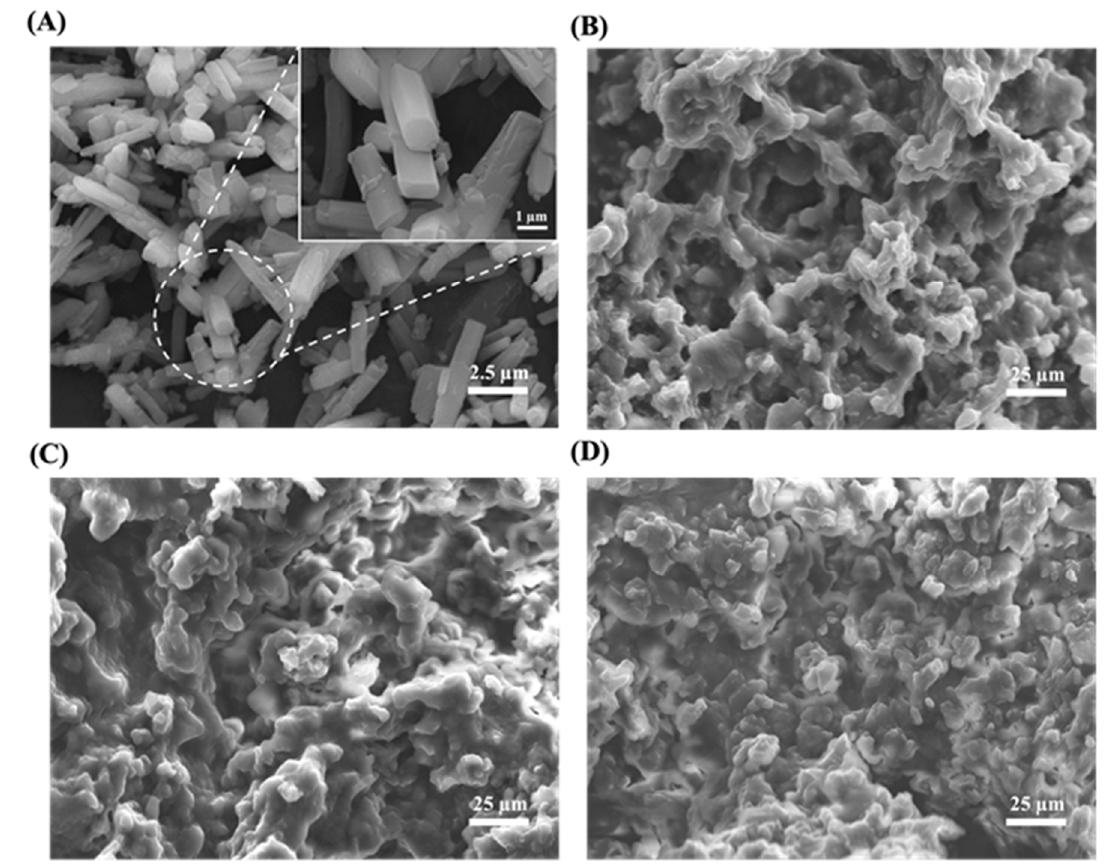
Figure 4. SEM images of pure curcumin and LSD-F3. ( A ): pure curcumin, ( B ): LSD-F3 at Day 0, ( C ) LSD-F3 after 2 month-storage at 4 °C, and ( D ) LSD-F3 after 2 month-storage at 25 °C.